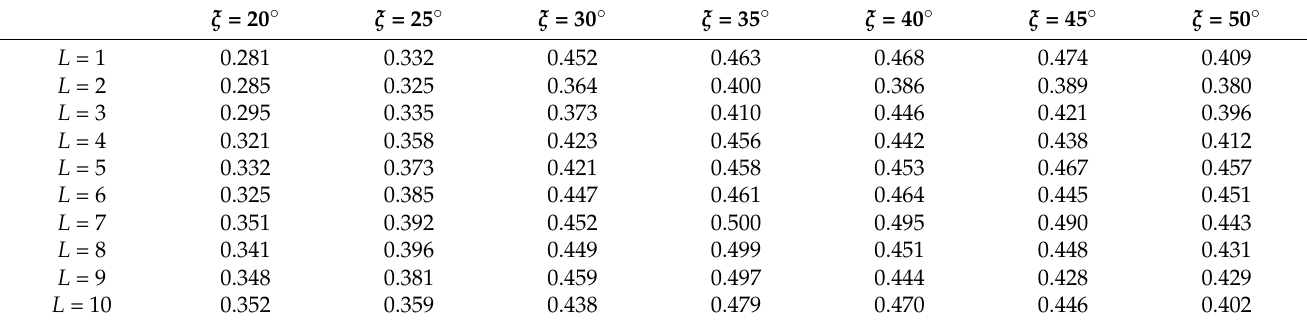
Table 3. Non-correlation value under different parameters of ξ and L .